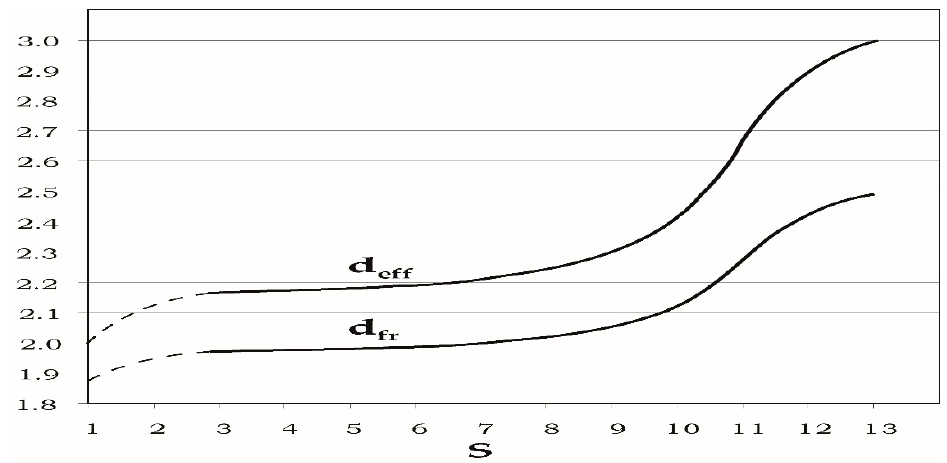
Figure 2. Effective fractal d fr and spatial d eff dimensions as a function of S.